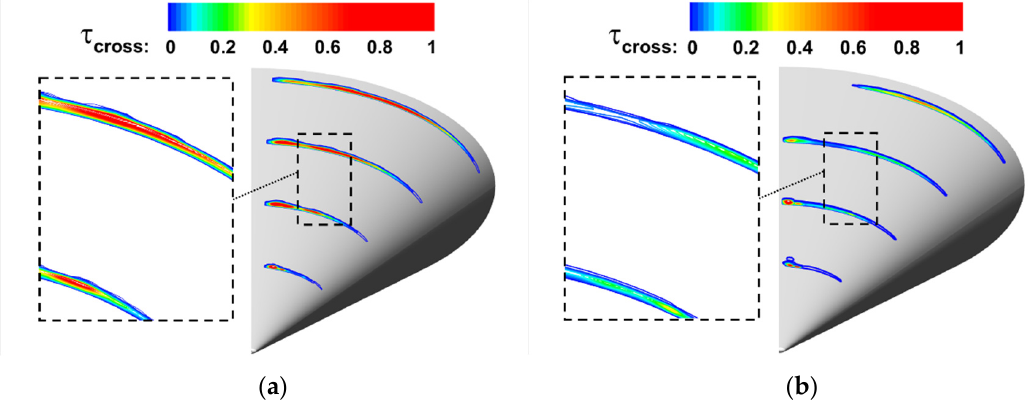
Figure 10. Comparison of τ cross distribution. ( a ) with aerodisk, ( b ) without aerodisk.